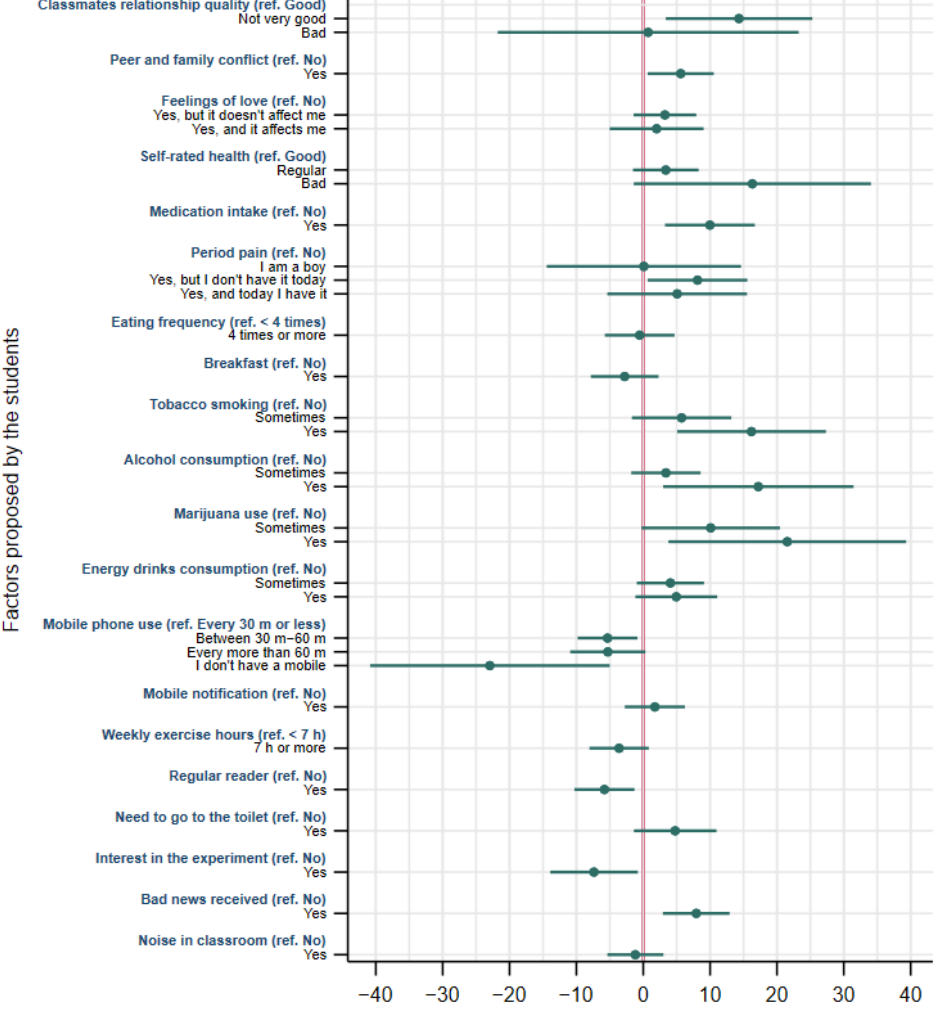
Figure 2. Percent change (95% confidence interval (CI) in attentiveness (HRT-SE)) among factors reported by the students in the co-created questionnaire with a p -value < 0.05 in the bivariate analysis ( n = 1658).